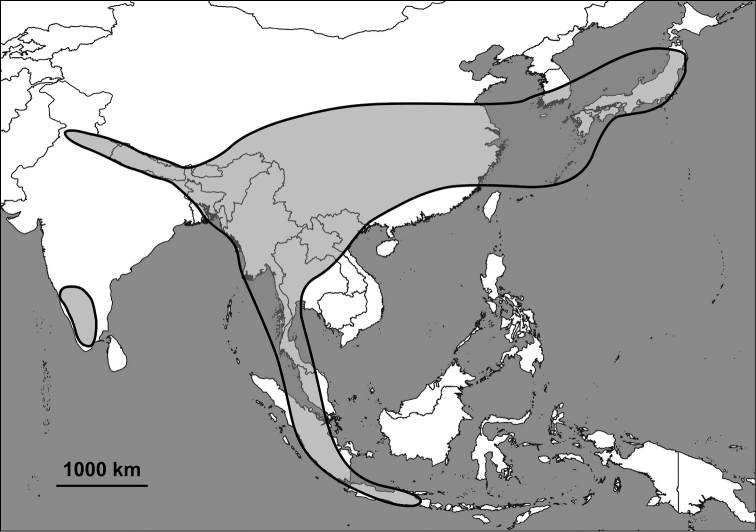
Distribution of Dicharax Kobelt & Möllendorff, 1900.